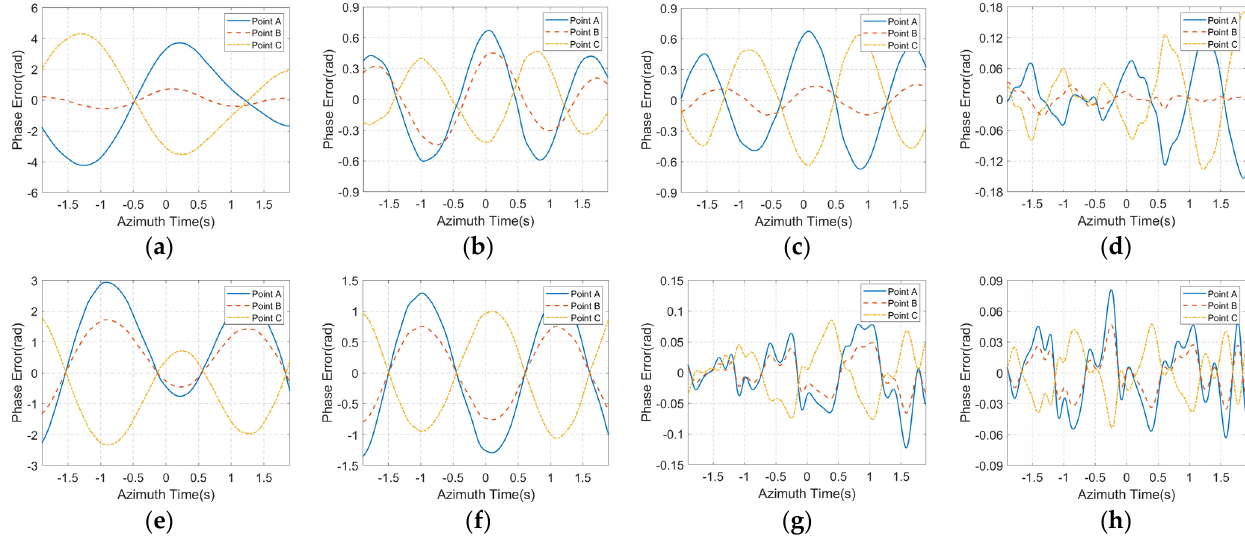
Figure 26. The residual phase errors of Point A, B, and C after phase compensation. ( a – d ) In the unanchored state; ( e – h ) in the navigating state. The number of sinusoidal terms used for fitting attitude angles from left to right is 1, 2, 3, 4.